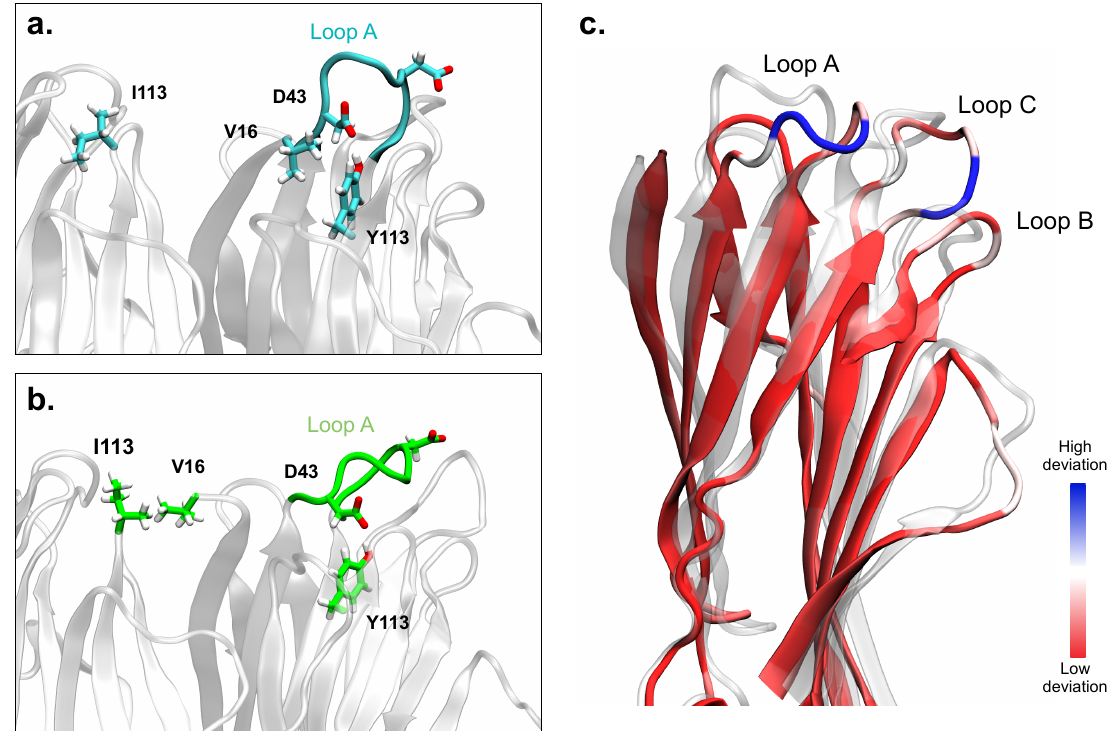
Figure 7. Representations of the cap domain of LukF in the dimer obtained from HADDOCK without the N-ter, at the beginning ( a ) and at the end ( b ) of the 500 ns-long MD simulation. ( c ) Structural alignment of the starting and final structures of the cap domain of LukF. The former is represented as a semi-transparent cartoon, while the latter is colored according to the RMSD between the two conformations. The largest deviations are observed in loop A (residues 43–48) and loop C (residues